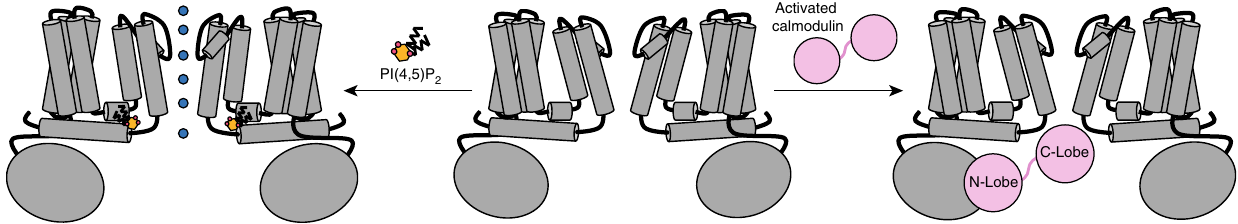
Fig. 7 TRPV5 activation by PI(4,5)P 2 and inactivation by CaM. A schematic representation of the proposed binding of both PI(4,5)P 2 and CaM to TRPV5, inducing either channel activation or inactivation. A dimer of TRPV5 is shown as a gray diagram, PI(4,5)P 2 is shown in orange, CaM is shown in pink and the blue circles indicate the fl ow of calcium ions